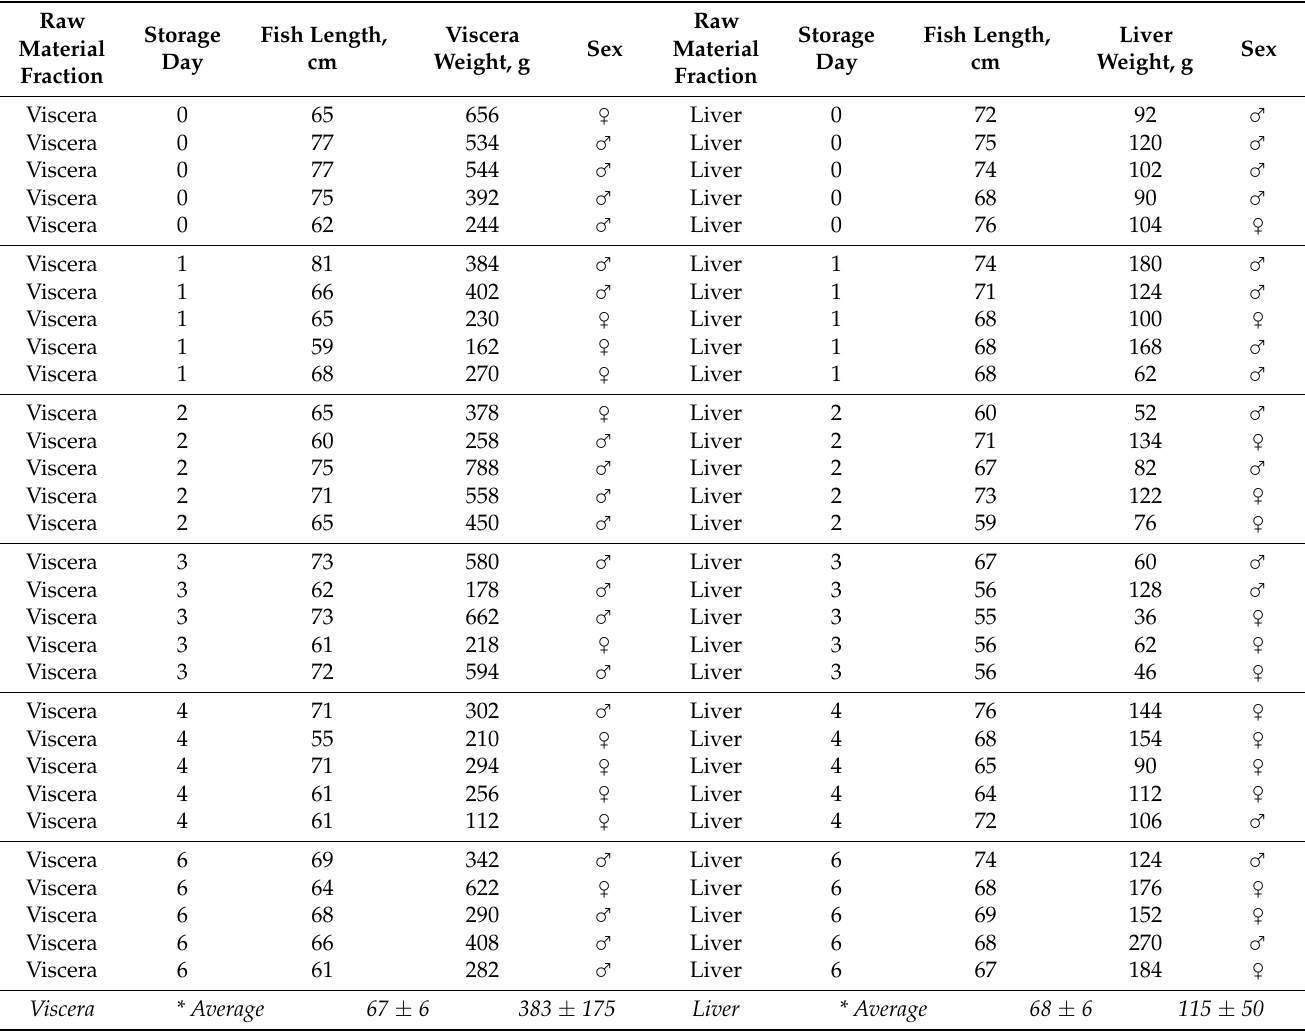
Table 1. Experimental data (fish length, raw material weight and sex) for raw material collected for each storage